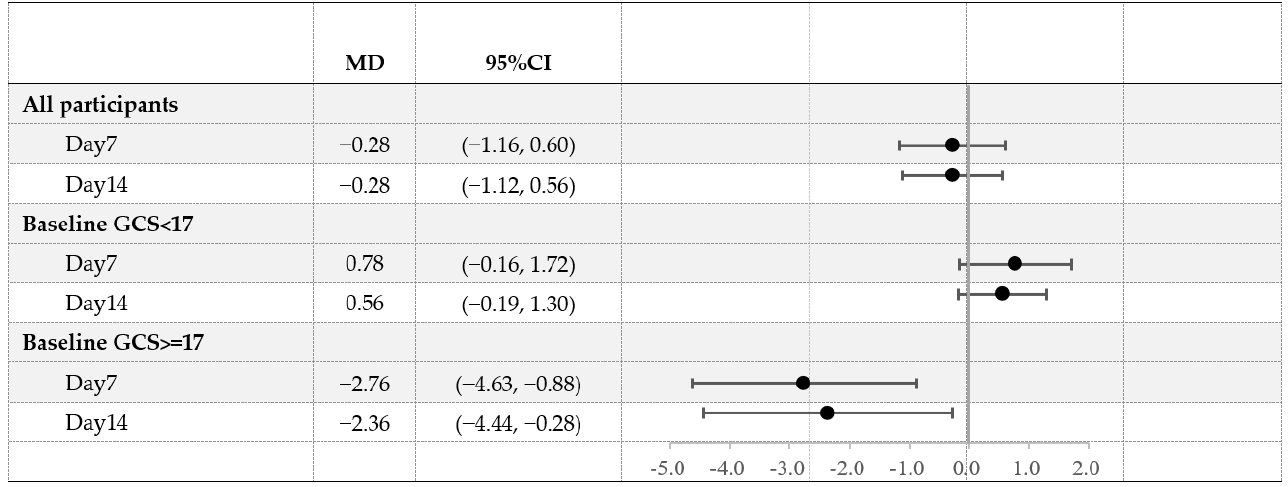
Figure 2. Least-square means (LS means) and 95% confidence intervals (CI) for Gut Comfort Compos- ite Score (GCS) by baseline GCS tertiles and group, day 7 and day 14. Models included adjustment for baseline GCS, age, sex, and breastfeeding. A negative value indicates that the GCS of the A2 GUM group was lower than that of the conventional milk